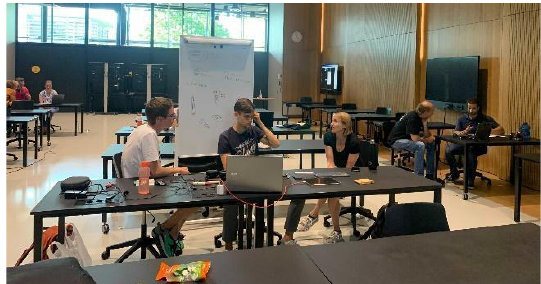
Fig. 1. Discussing with experts helped a lot to stretch ideas without making them